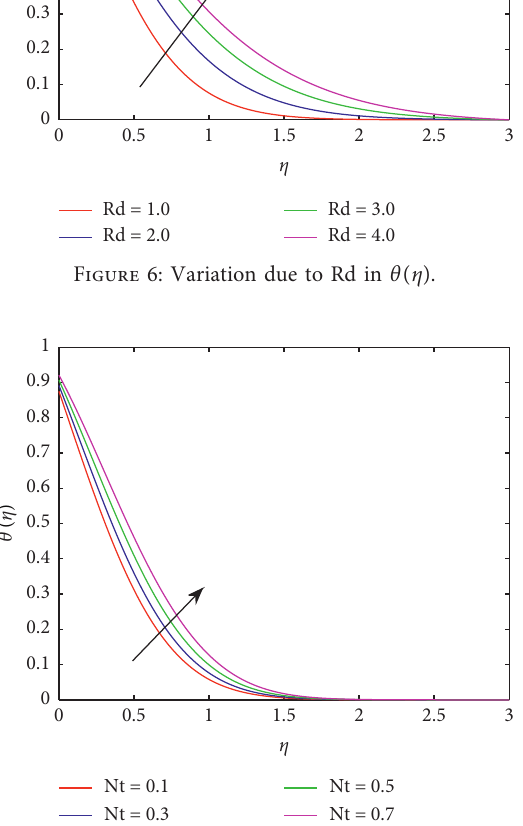
Figure 7: Variation due to Nt in θ ( η ) .